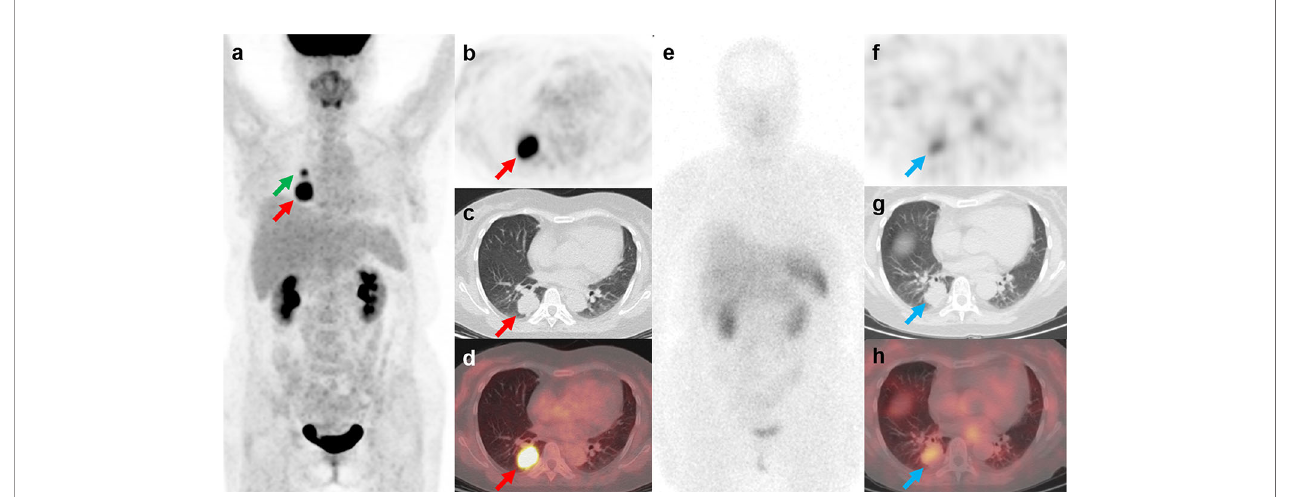
FIGURE 3 | 18 F-FDG PET/CT and 99m Tc-HYNIC-TOC SPECT/CT fi ndings in a representative case of cryptococcosis (Patient, 3). A 34-year-old woman with ectopic Cushing syndrome underwent 18 F-FDG PET/CT and 99m Tc-HYNIC-TOC SPECT/CT for the detection of ACTH-secreting tumor. 18 F-FDG PET/CT showed a mass in the right lung (A – D ; red arrows, 3.5cm, SUVmax, 12.4). A hypermetabolic nodule near the right hilum was also noted ( A ; green arrow, 1.4cm, SUVmax, 5.7). The mass demonstrated positive uptake on 99m Tc-HYNIC-TOC SPECT/CT ( E – H ; blue arrows), and the nodule showed slightly increased uptake. The two lesions were then surgically removed and histopathological results con fi rmed pulmonary cryptococcosis. Three weeks after surgery, the patient developed severe headache and fever symptoms. Cryptococcus cerebrospinal culture was positive, suggesting cryptococcal meningitis. The patient responded poorly to the antibiotic therapy and died of cerebral